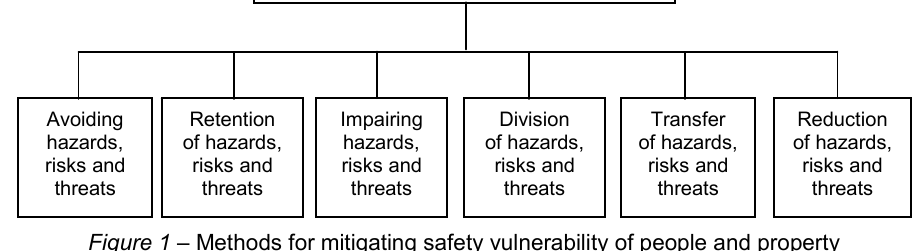
Figure 1 – Methods for mitigating safety vulnerability of people and property from the effects of explosive material explosions Рис . 1 – Методы по предотвращению и смягчению последствий взрыва взрывчатых